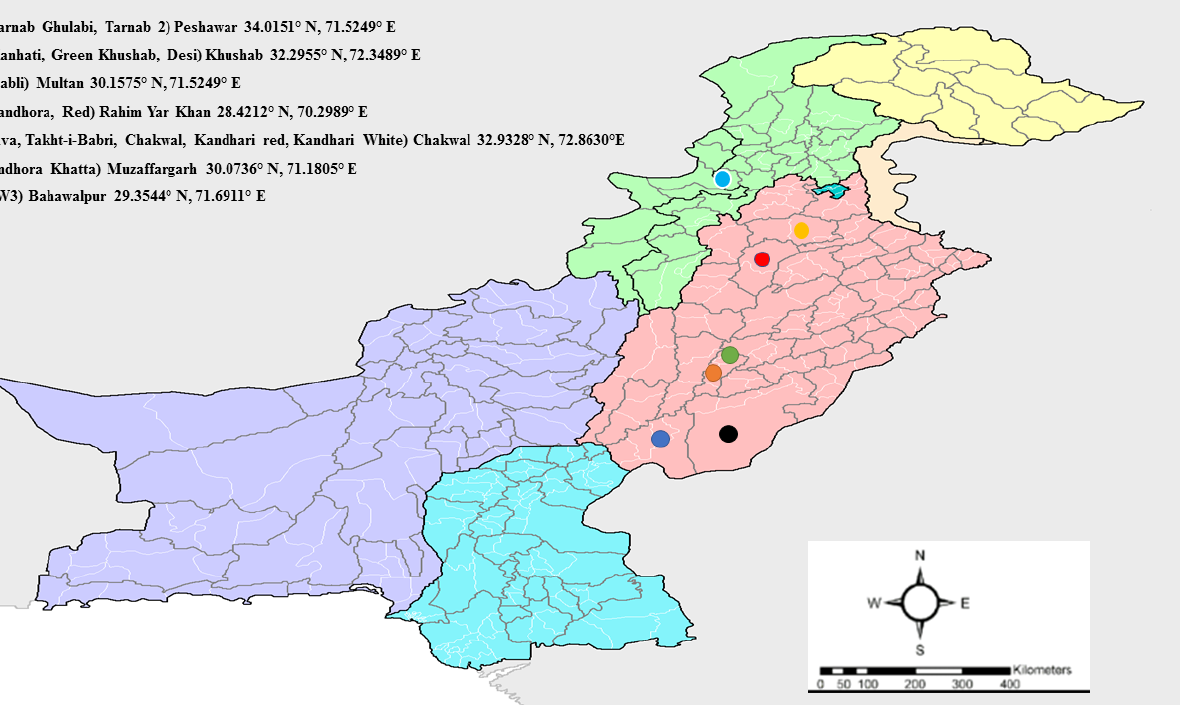
Figure 6. Distribution of pomegranate genotypes based on their site of collection from Pakistan. Colored dots show different collection locations on the map. Table 3. Characteristics of pomegranate germplasm used for experiment [39,40].